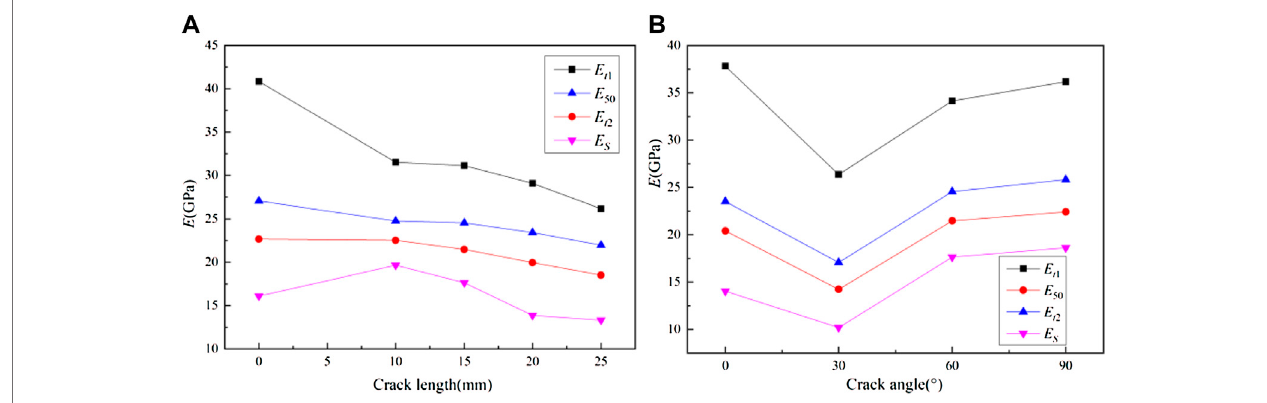
FIGURE 7 | Elastic and deformation moduli of samples containing single cracks for (A) crack length (B) crack